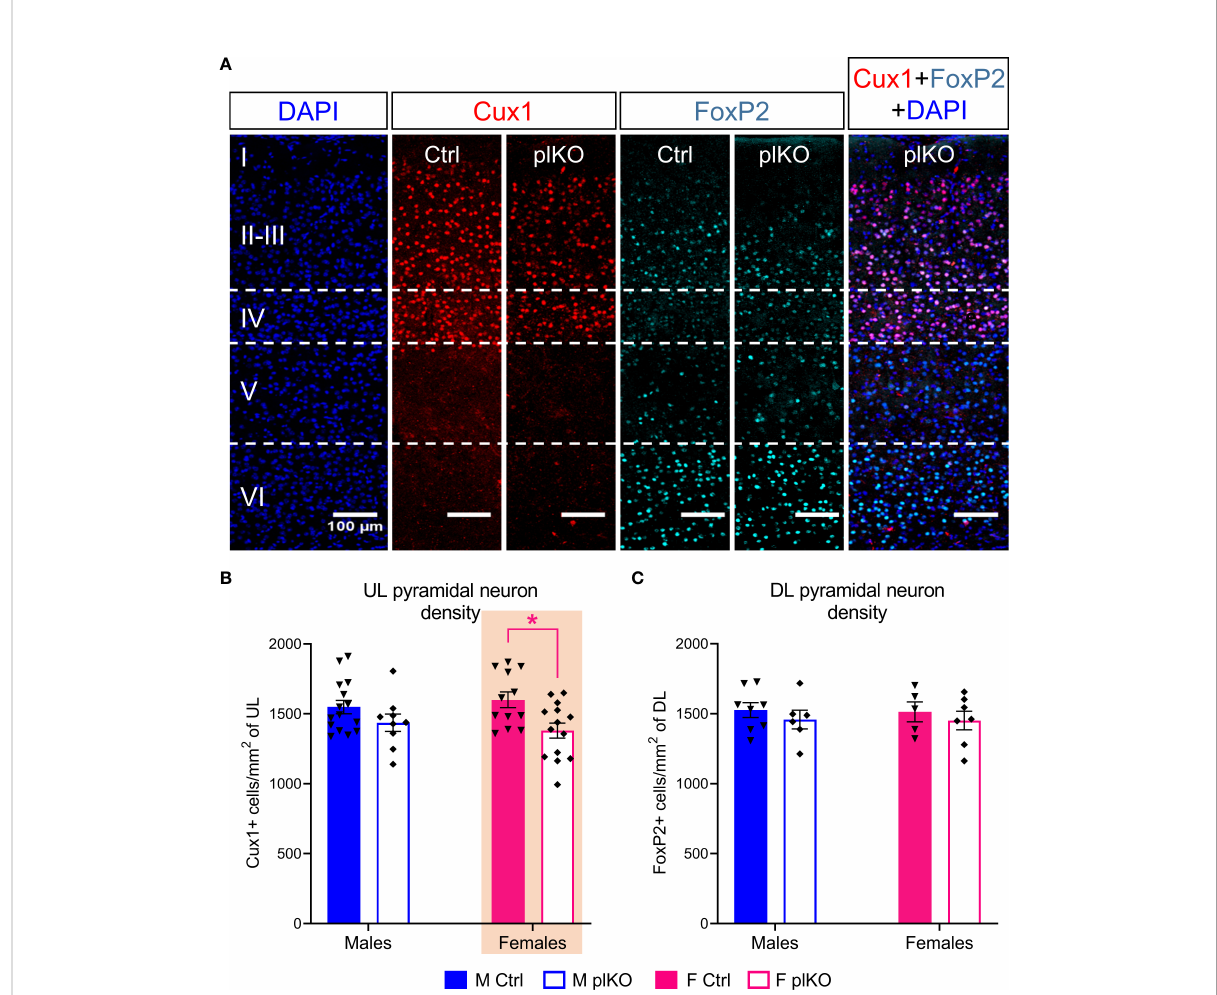
FIGURE 3 Long-term effect of placental ALLO insuf fi ciency on cortical lamination. (A) Representative immuno fl uorescent staining for Cux1 (red) and FoxP2 (cyan) in the female S1 area at P30. (B, C) Quanti fi cation of (A) shows that the density of Cux1+ upper layer principal cells is signi fi cantly decreased (layers II-IV) in plKO females but that the density of FoxP2+ deeper layer principal cells remained unaltered. n = 8-15 M Ctrl, 5-12 F Ctrl, 6-9 M plKO, 7-14 F plKO. Data presented as mean ± SEM. Two-way sex by genotype ANOVA with Sidak ’ s post-hoc comparison test: *p < 0.05 identi fi ed in magenta for females. Cux1, Cut like homeobox 1; F, female; FoxP2, Forkhead box protein P2; M, male. DL, deep layer; UL, upper